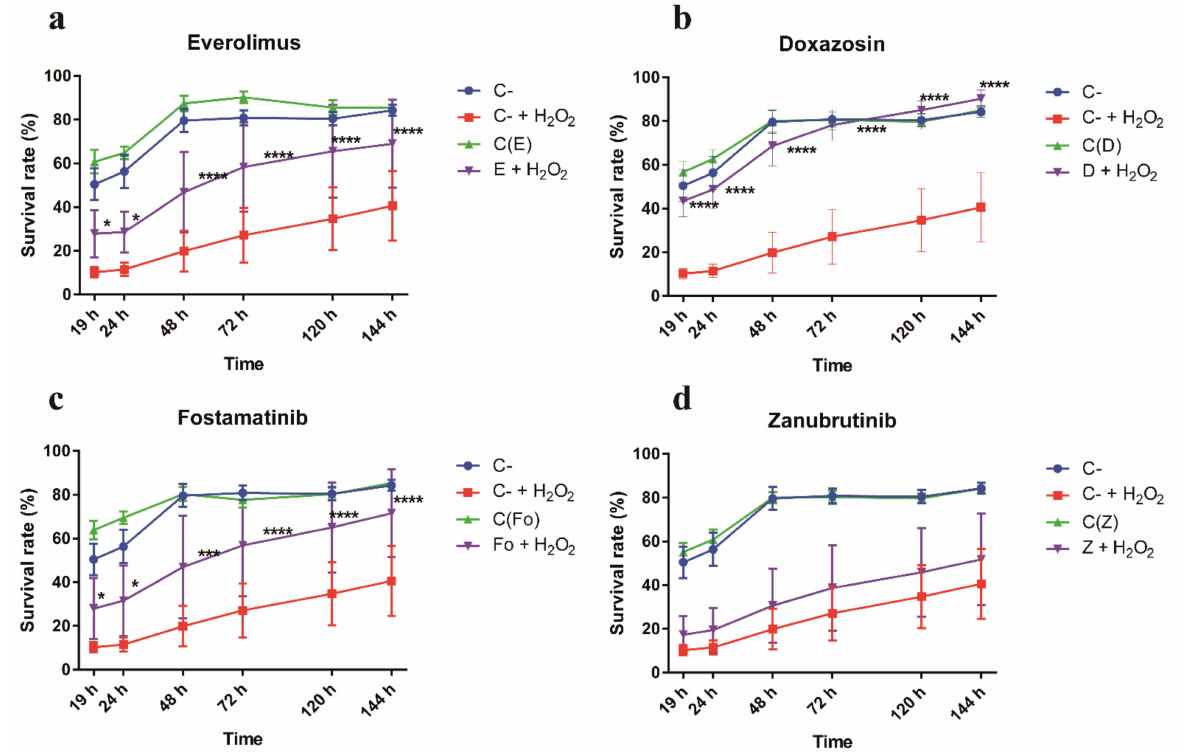
Figure 7. Selected drugs increased cell survival rate in CF airway epithelial cells. Alamar Blue cell viability assay at different times after strong oxidative stress induction. Spectrophotometric quantification of the mean survival rate of 6CFSMEo- cells under strong oxidative stress conditions in presence of the respective drugs. The drug working concentrations were: ( a ) everolimus (E; 5 µ M), ( b ) doxazosin (D; 10 µ M), ( c ) fostamatinib (Fo; 1 µ M), and ( d ) zanubrutinib (Z; 10 µ M); H 2 O 2 was added at 0.9 mM. C-, untreated cells; C- + H 2 O 2 , untreated cells in presence of H 2 O 2 ; C(X), cells treated with the respective drug; X + H 2 O 2 , cells treated with the respective drug in the presence of H 2 O 2 . Data are expressed as means ± SD; E: n = 5; D: n = 6; Fo: n = 6; Z: n = 2, with three technical replicates/each. * p < 0.05, *** p < 0.001, **** p < 0.0001 compared with control (C- + H 2 O 2